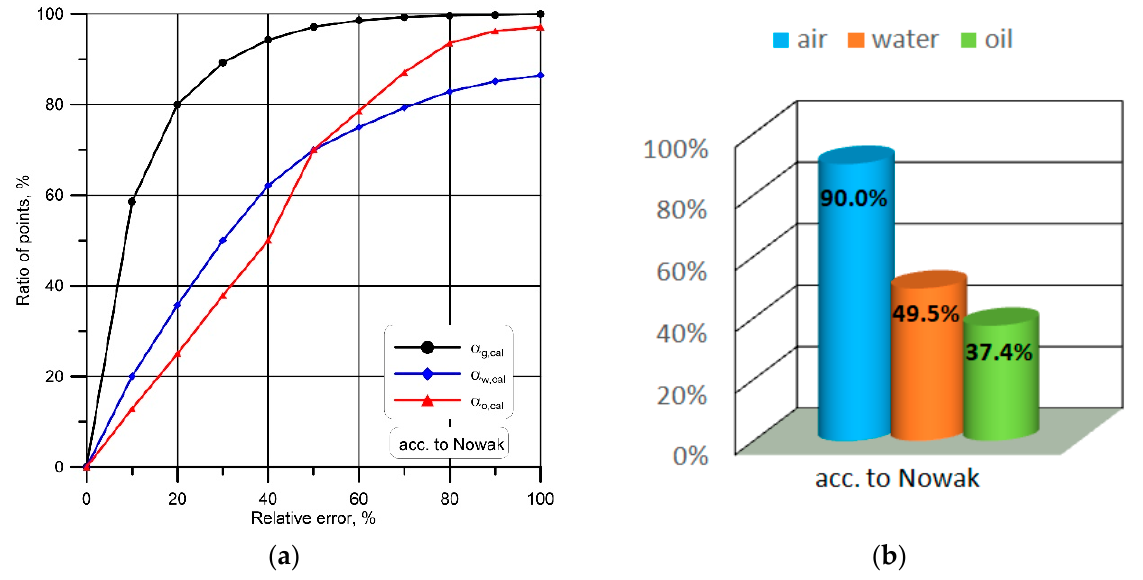
Figure 8. Statistical analysis of method applied for determining void and volume fraction of phases for downward three-phase oil–water–air flow ( a ), and ( b ) values of experimental points located within the range of <30% of the MAE of experimental points, in accordance with the Pendyk method [45].